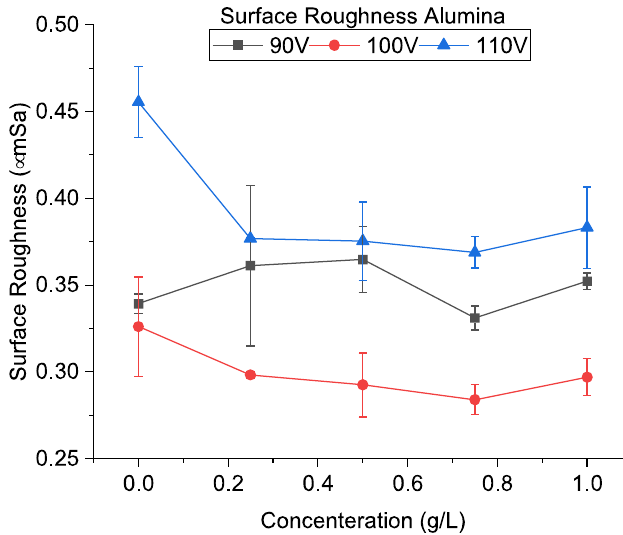
Figure 18. Surface roughness using alumina-mixed